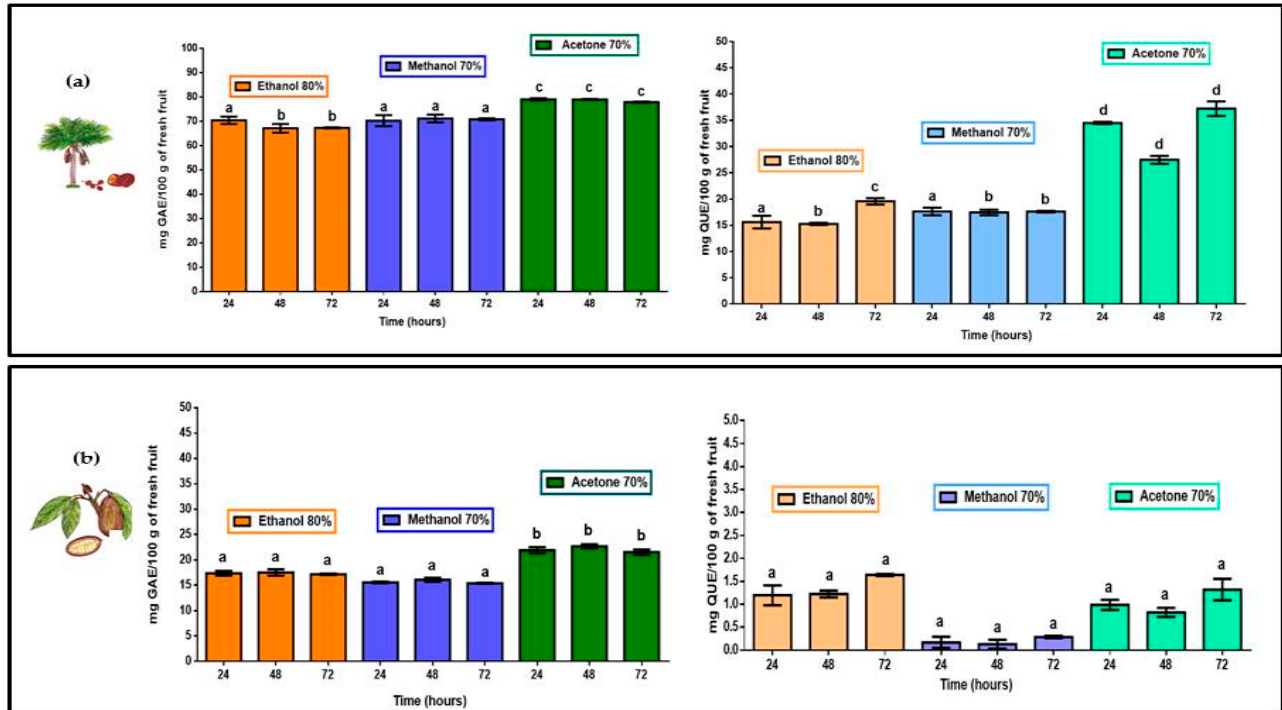
Figure 2. TPC (mg of gallic acid equivalents) and TFC (mg quercetin equivalents) per 100 g of fresh pulp in ( a ) M. flexuosa (aguaje) and for ( b ) T. grandiflorum (copoazú) extracts in 80% ethanol, 70% methanol and 70% acetone at three different times. Data are means and lower-case letters represent significant differences based on ANOVA followed by Tukey test ( p < 0.05).